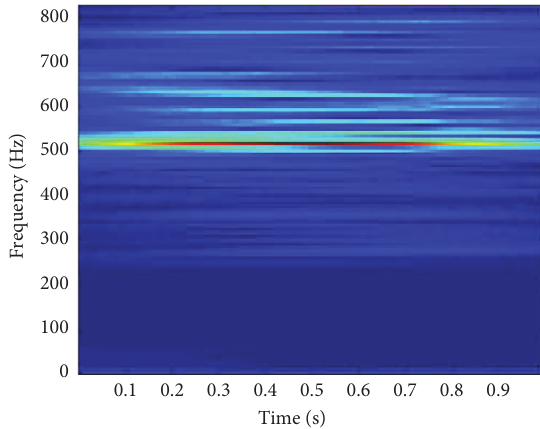
Figure 12: Time-frequency matrix of the train bearing.